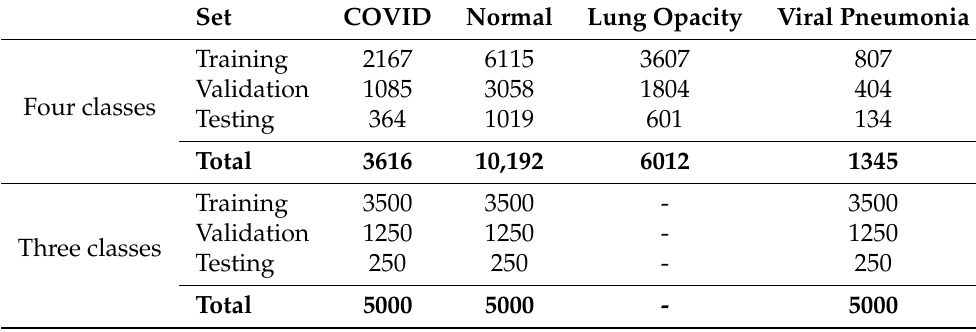
Figure 5. Sample datasets used in this work: ( a ) sample with COVID-19, ( b ) sample with lung opacity, ( c ) sample with normal, and ( d ) sample viral pneumonia Table 2. Dataset composition for both three and four